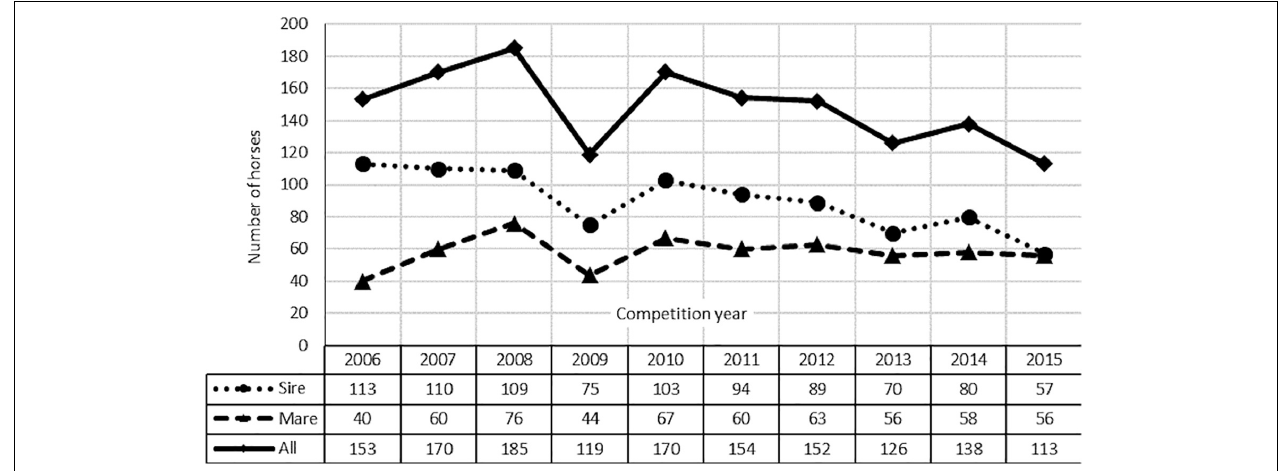
FIGURE 1 | Number of horses starts in Polish Championships for Young Horses in 2006–2015.